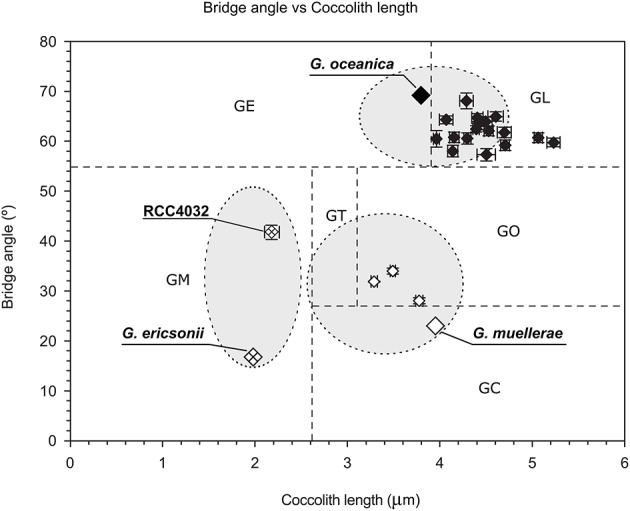
Scatter plot of mean coccolith length vs. mean bridge angle of Gephyrocapsa morphotypes defined in Holocene sediment samples (Gephyrocapsa Equatorial (GE), Gephyrocapsa Oligotrophic (GO), Gephyrocapsa Transitional (GT), Gephyrocapsa Cold (GC), Gephyrocapsa Larger (GL), Gephyrocapsa Minute (GM)) with values plotted from the original descriptions of (extant) Gephyrocapsa ericsonii, Gephyrocapsa muellerae, and Gephyrocapsa oceanica (gray area within ellipses represents the range of values generally applied for these species), from Gephyrocapsa ericsonii isolate RCC4032, and from 3 Gephyrocapsa muellerae and 16 Gephyrocapsa oceanica culture strains. Error bars represent the standard error. After Bollmann (1997) and Young et al. (2003).